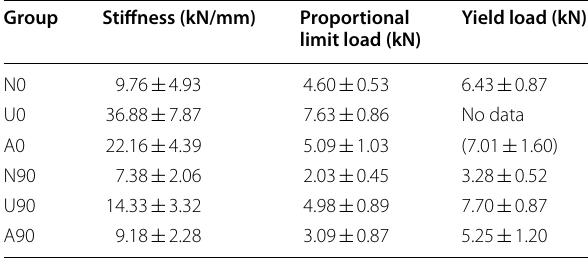
Yield load of group A0 can be obtain from 18 specimens out of 20 specimens